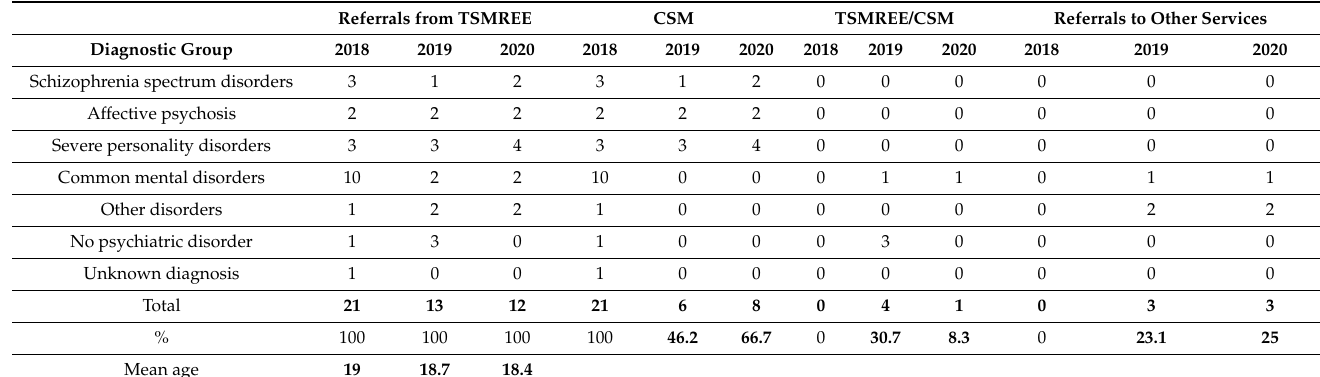
Table 1. TSMREE/CSM (17-19)—Distribution by diagnostic group. The bold indicates total. Referrals from TSMREE CSM TSMREE/CSM Referrals to Other